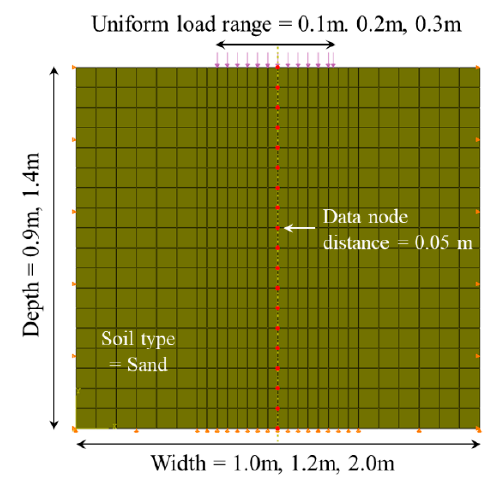
Figure 6. Finite element analysis (FEA) model produced for verification.